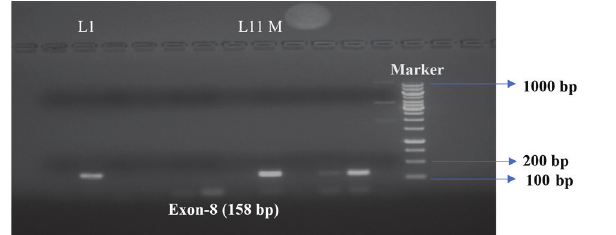
Figure 8. Agarose gel electrophoresis of PCR results of Exon-8 (TP53) Agarose gel electrophoresis (1.5%) results of exon 8 of the human TP53 gene. L1,L7,L9,L10:amplified bands (158bp) of exon 8, L12/M: DNA-marker